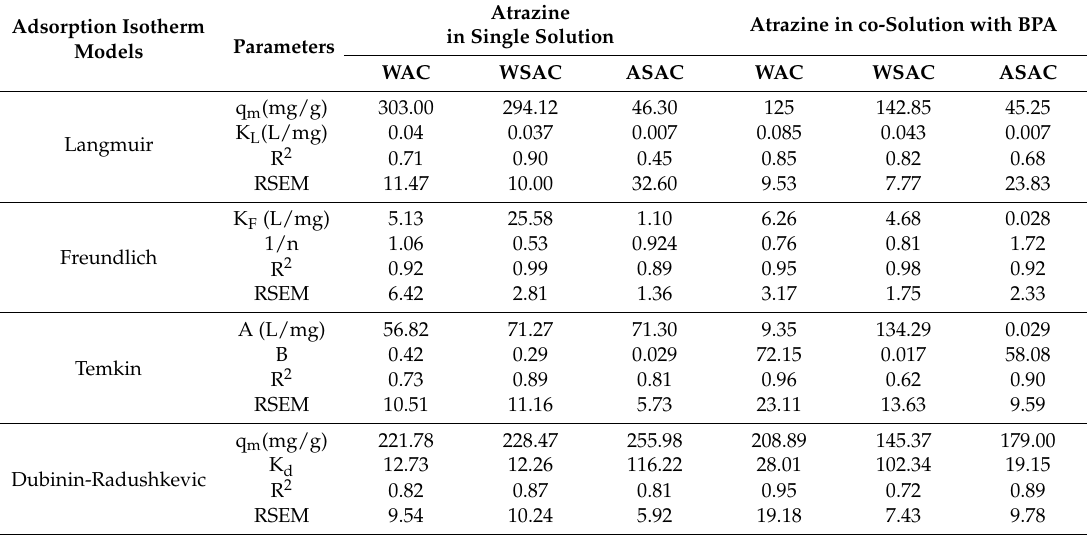
Table 7. Effect of BPA on adsorption isotherm parameters of atrazine onto